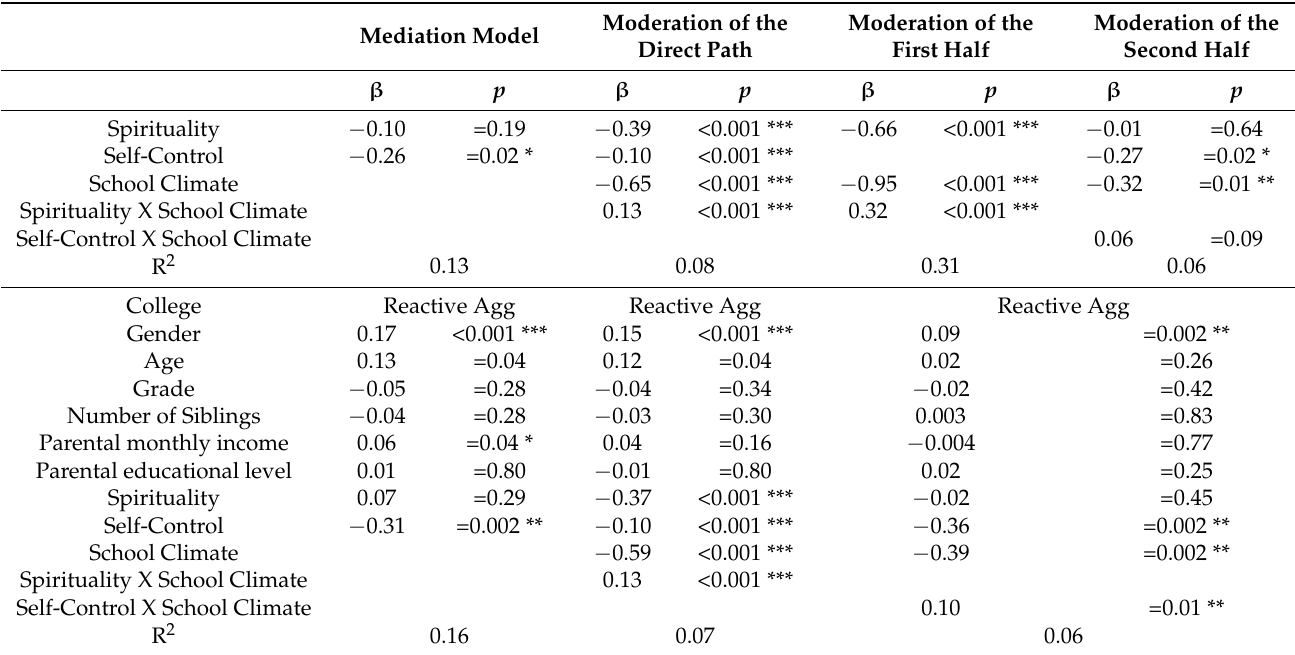
Figure 3 . first half path with school climate being the moderator . Note: XINY = spirituality, SELF = self-control, SC = school climate.